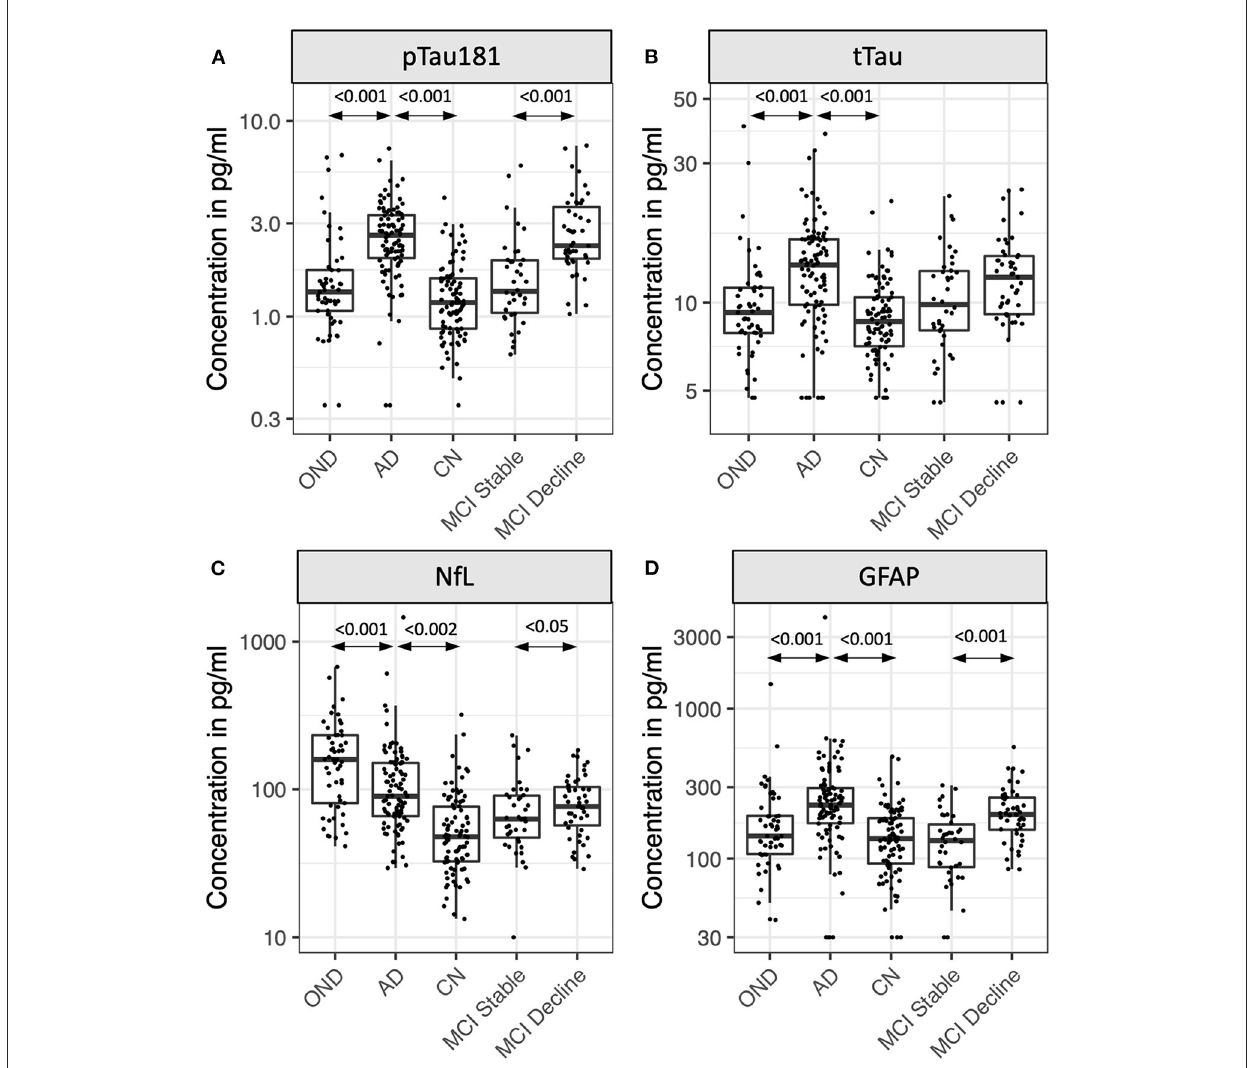
FIGURE3 Plasma levels of pTau181 (A) , tTau (B) , NfL (C) , and GFAP (D) in participants with Alzheimer’s disease (AD), other neurodegenerative diseases (OND), normal cognition (CN), and mild cognitive impairment (MCI). MCI participants were stratified by the absence (stable) or presence (decline) of cognitive decline during 4 years of follow-up. Box plots show median, 25th/75th percentile, and smallest/largest value within 1.5 × the interquartile below/above the median. Select p -values are indicated in graph.